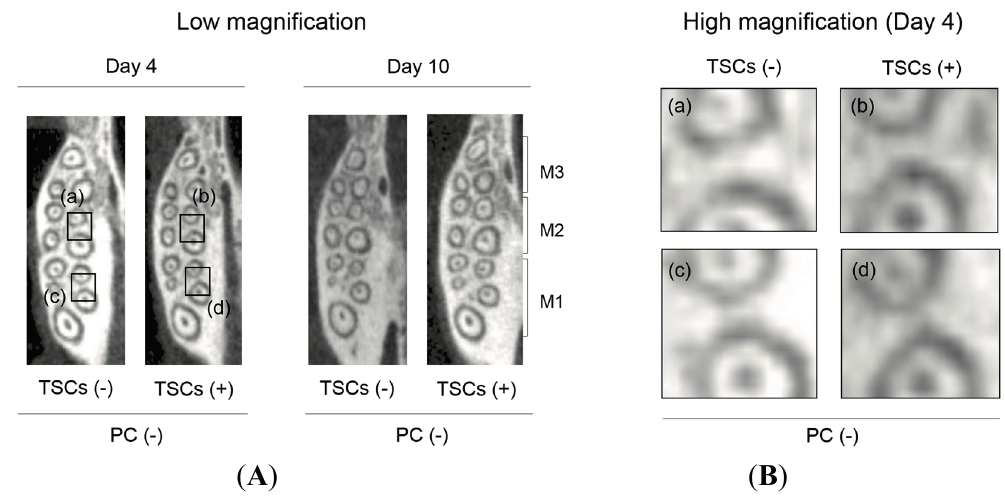
Figure 3. μ CT image of alveolar bone without power chain (PC) treatment. ( A ) Low magnification. Squares ( a – d ): magnified area; ( B ) High magnification. TSCs: